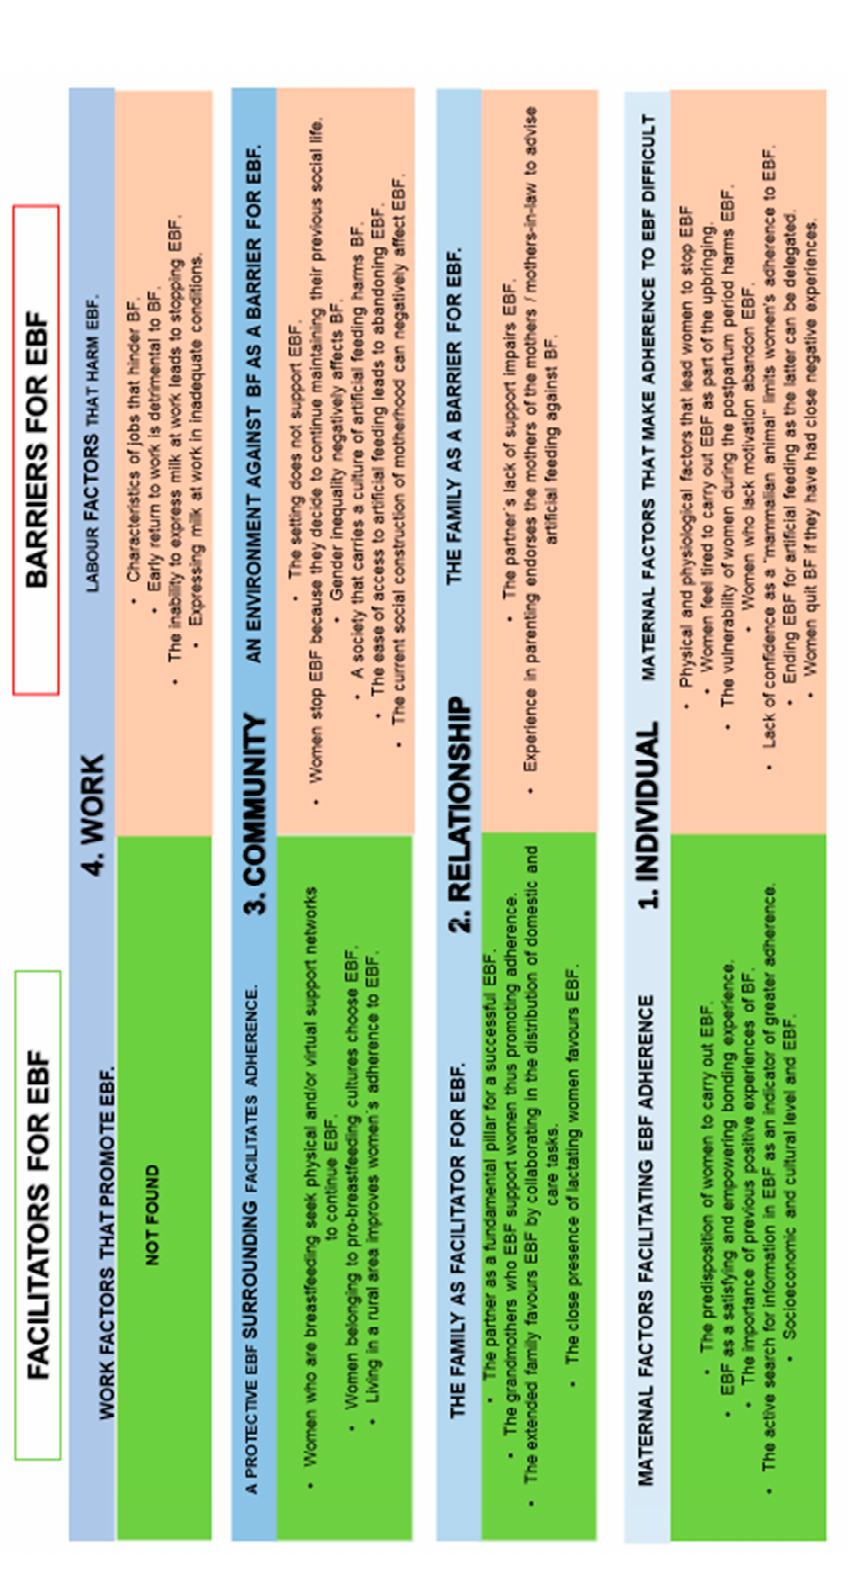
Figure 2. Facilitators and barriers for EBF in relation to the biopsychosocial sphere of women.